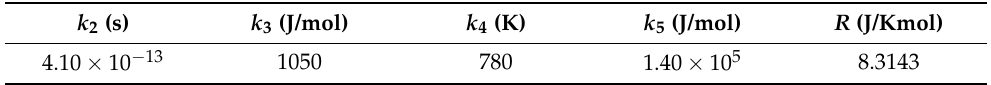
Table 1. k 2 – k 5 parameters for TTP diagram of AA7075-T6 [1] and the gas constant. Adapted with permission from Elsevier,